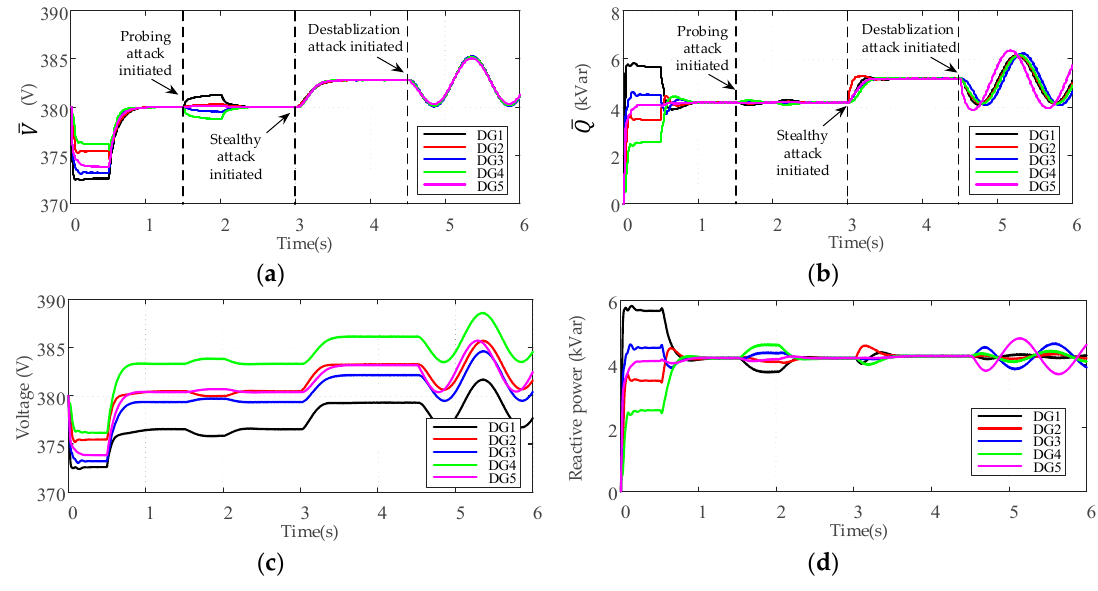
Figure 3. The different adverse effects of FDI attack on the proposed cooperative controller: ( a ) Average voltage estimate; ( b ) Average reactive power estimate; ( c ) Voltages of DGs; ( d ) Reactive power of DGs.